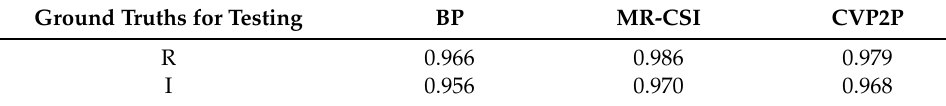
Table 4. CC results for the reconstructions in Figure